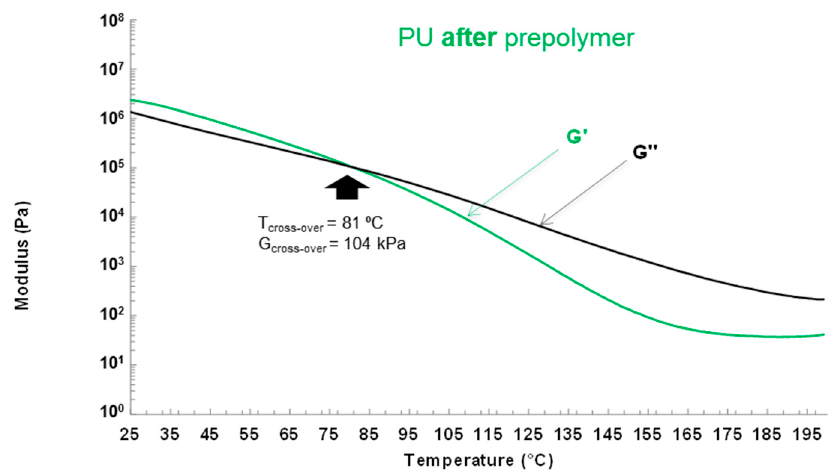
Figure 15. Variation of the storage (G’) and loss (G”) moduli as a function of the temperature for PU films. Plate–plate rheology experiments.